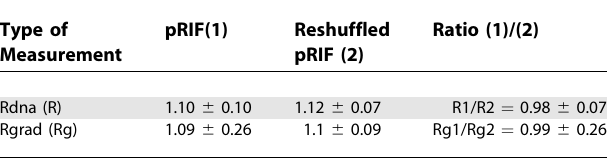
Table 2. Reshuffling Simulated Foci Positions along Synthetic Tracks Lead to the Same Relative DNA Values as Simulations